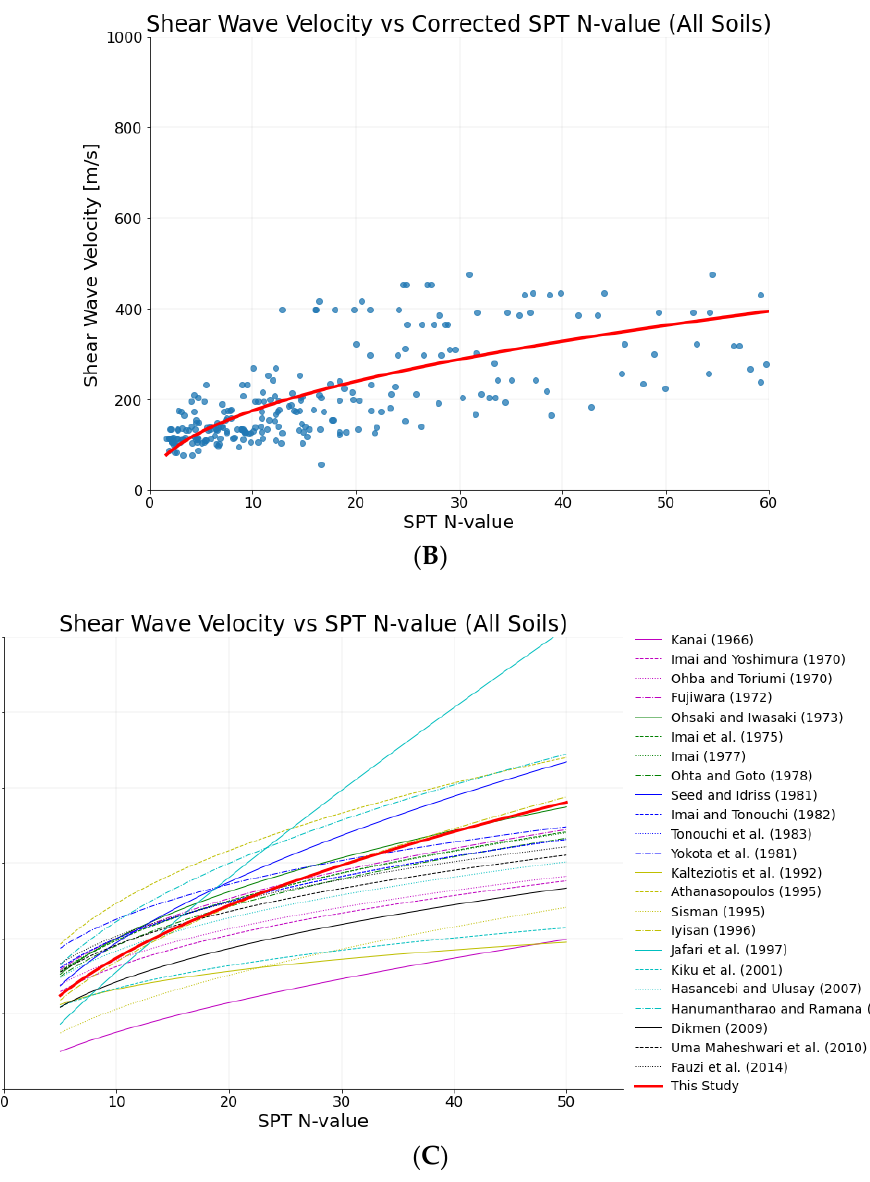
Figure 4. ( A ) . Uncorrected SPT-N and V s pairs for all soils and the determined empirical correlation. ( B ). Corrected SPT-N and V s pairs for all soils and the determined empirical correlation. ( C ). Comparison of the proposed empirical correlation for all soil types and other published works [8,9,12 – 16,21,23,26,28,30,34,35,52,53,57,61,63 – 65,67,72].